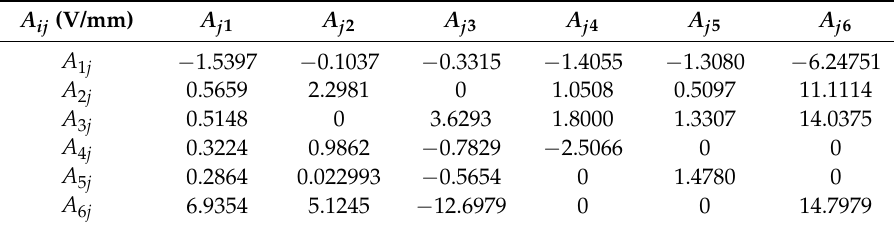
Table 2. Calibration result of parameter A .